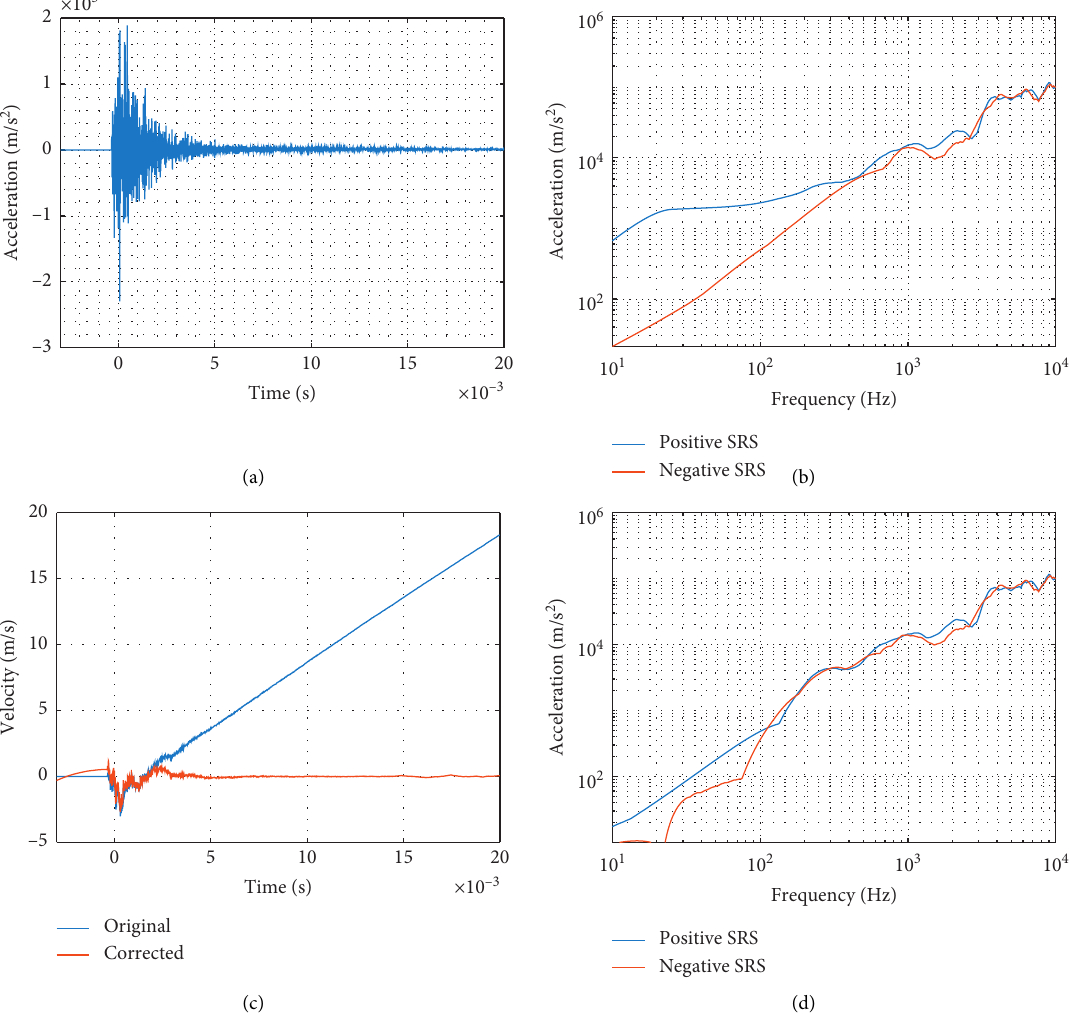
Figure 2: Zero shift correction. (a) Acceleration-time history. (b) SRS ( Q � 10) before correction. (c) Velocity-time history. (d) SRS ( Q � 10) after